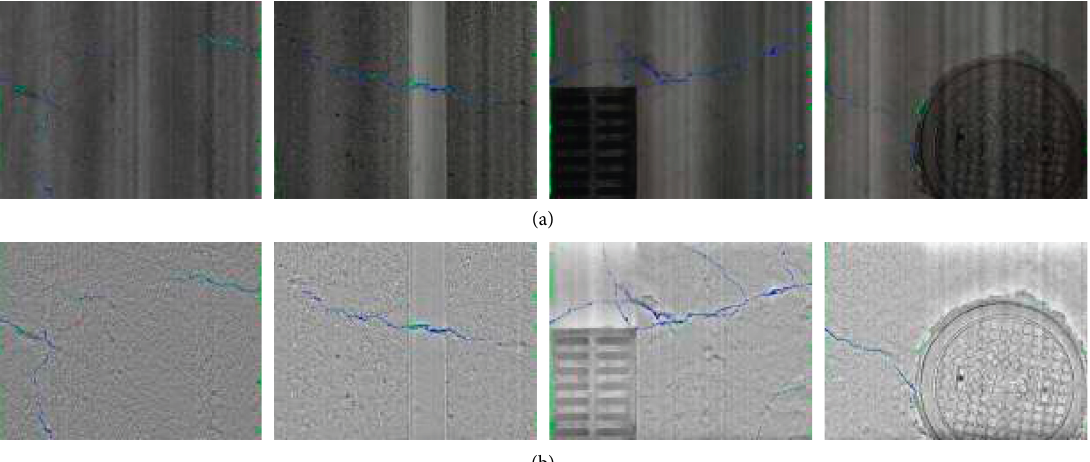
Figure 10: Crack segmentation by the U-Net network model from (a) the original image; (b) the image after dodging. (The blue area is the accurately segmented crack; the green is the pseudo